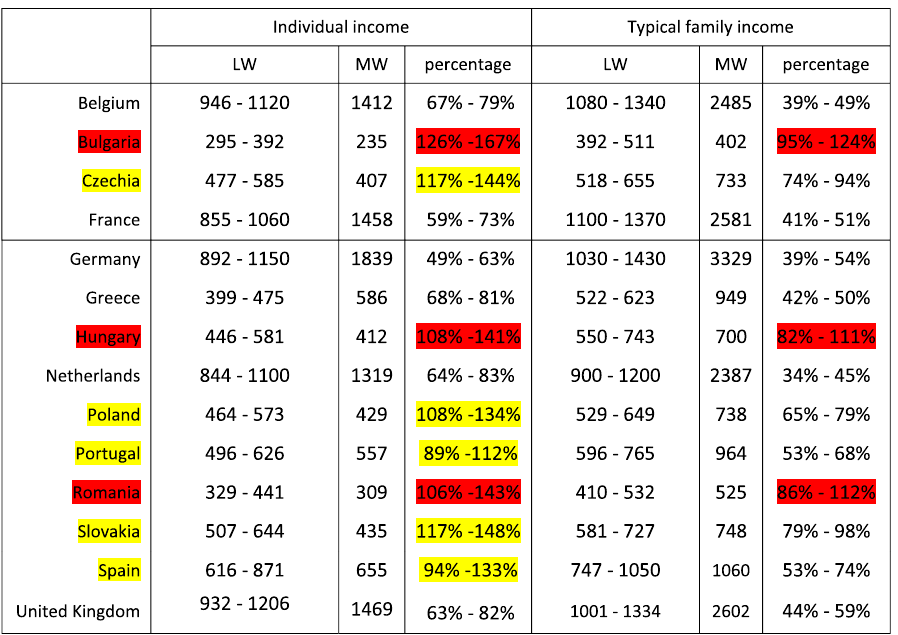
Table 2 Comparison of living and minimum